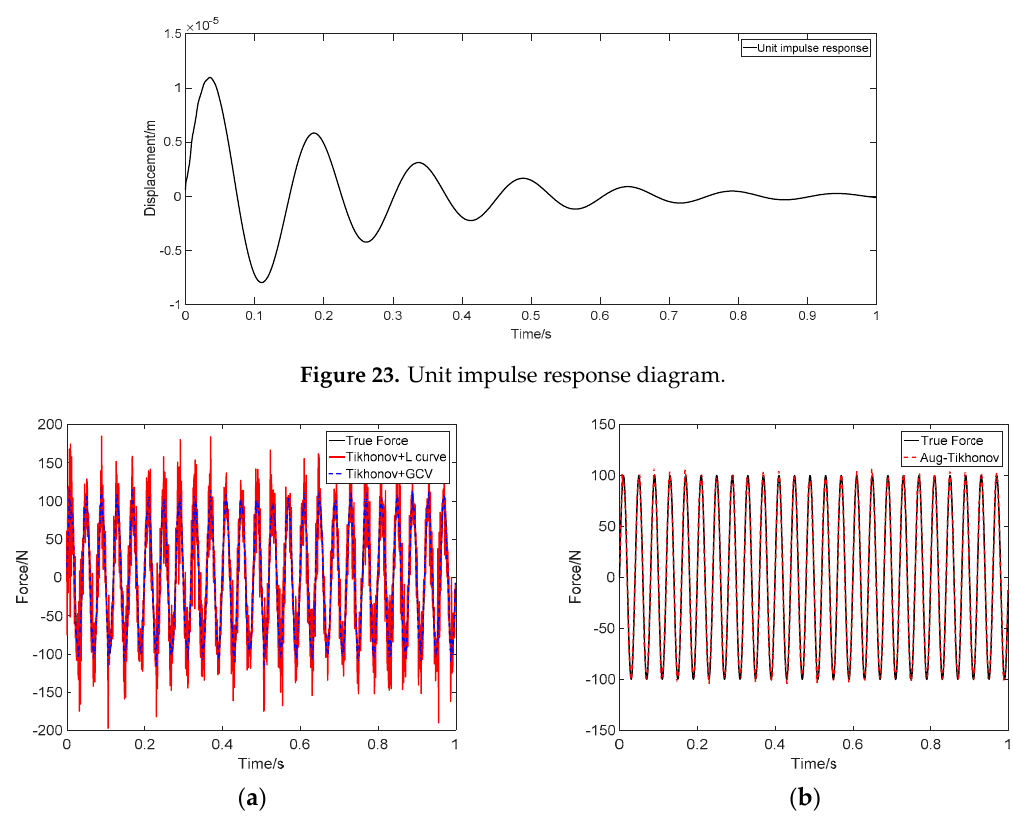
Figure 24. Identification result of sinusoidal load at SNR 40 dB on cantilever: ( a ) Tikhonov method; ( b ) the proposed method.